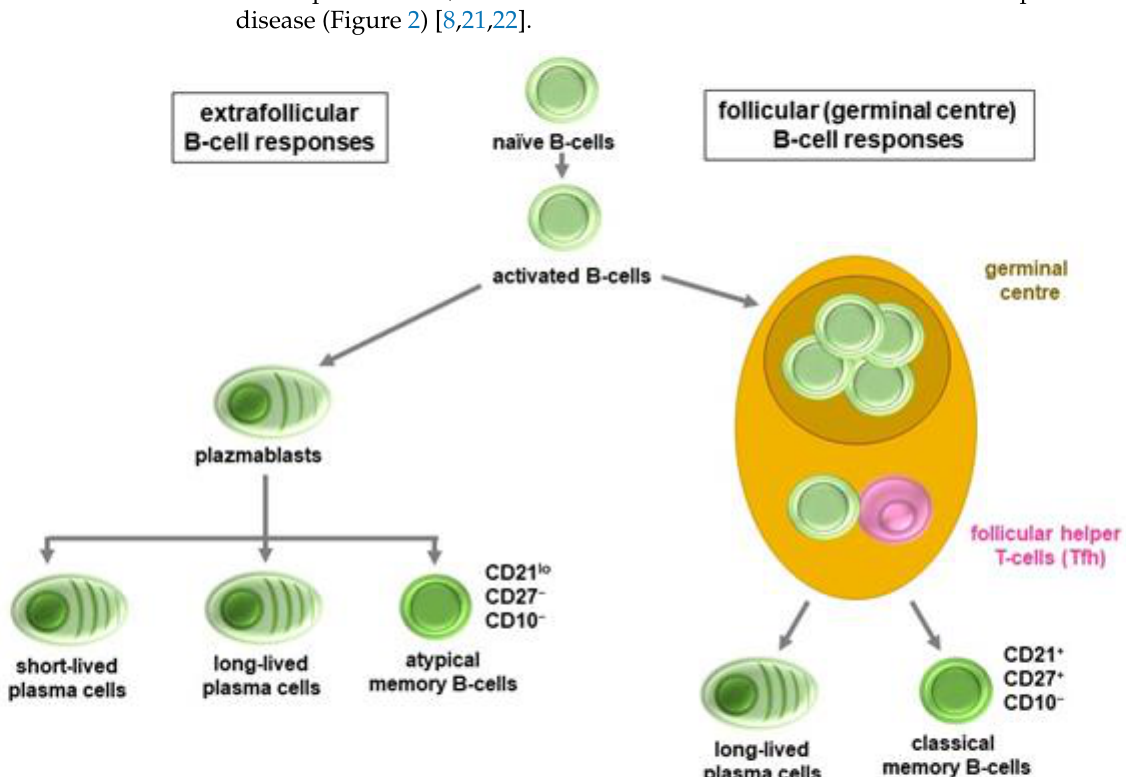
Figure 2. Extrafollicular and follicular B-cell responses.